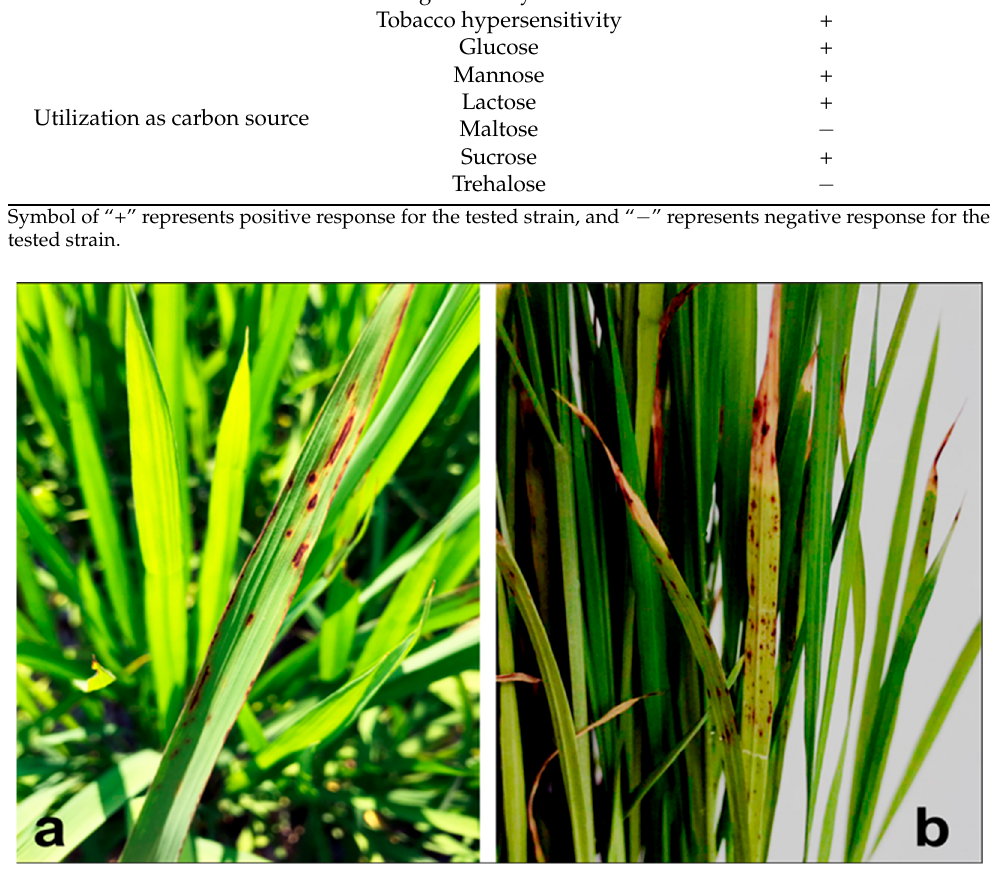
Table 1. Origin and main biochemical characteristics of P. s. pv. syringae isolates. Characteristics Reaction Growth at 41 ◦ C − Detection of syrB + Gram staining − Hydrolysis gelatin − Nitrate reductase − Levan formation + Oxidase − Symbol of “+” represents positive response for the tested strain, and “-” represents negative response for the Potato rot − LOPAT Test tested strain. Arginine dihydrolase + Tobacco hypersensitivity + Glucose + Mannose + Lactose Utilization as carbon source